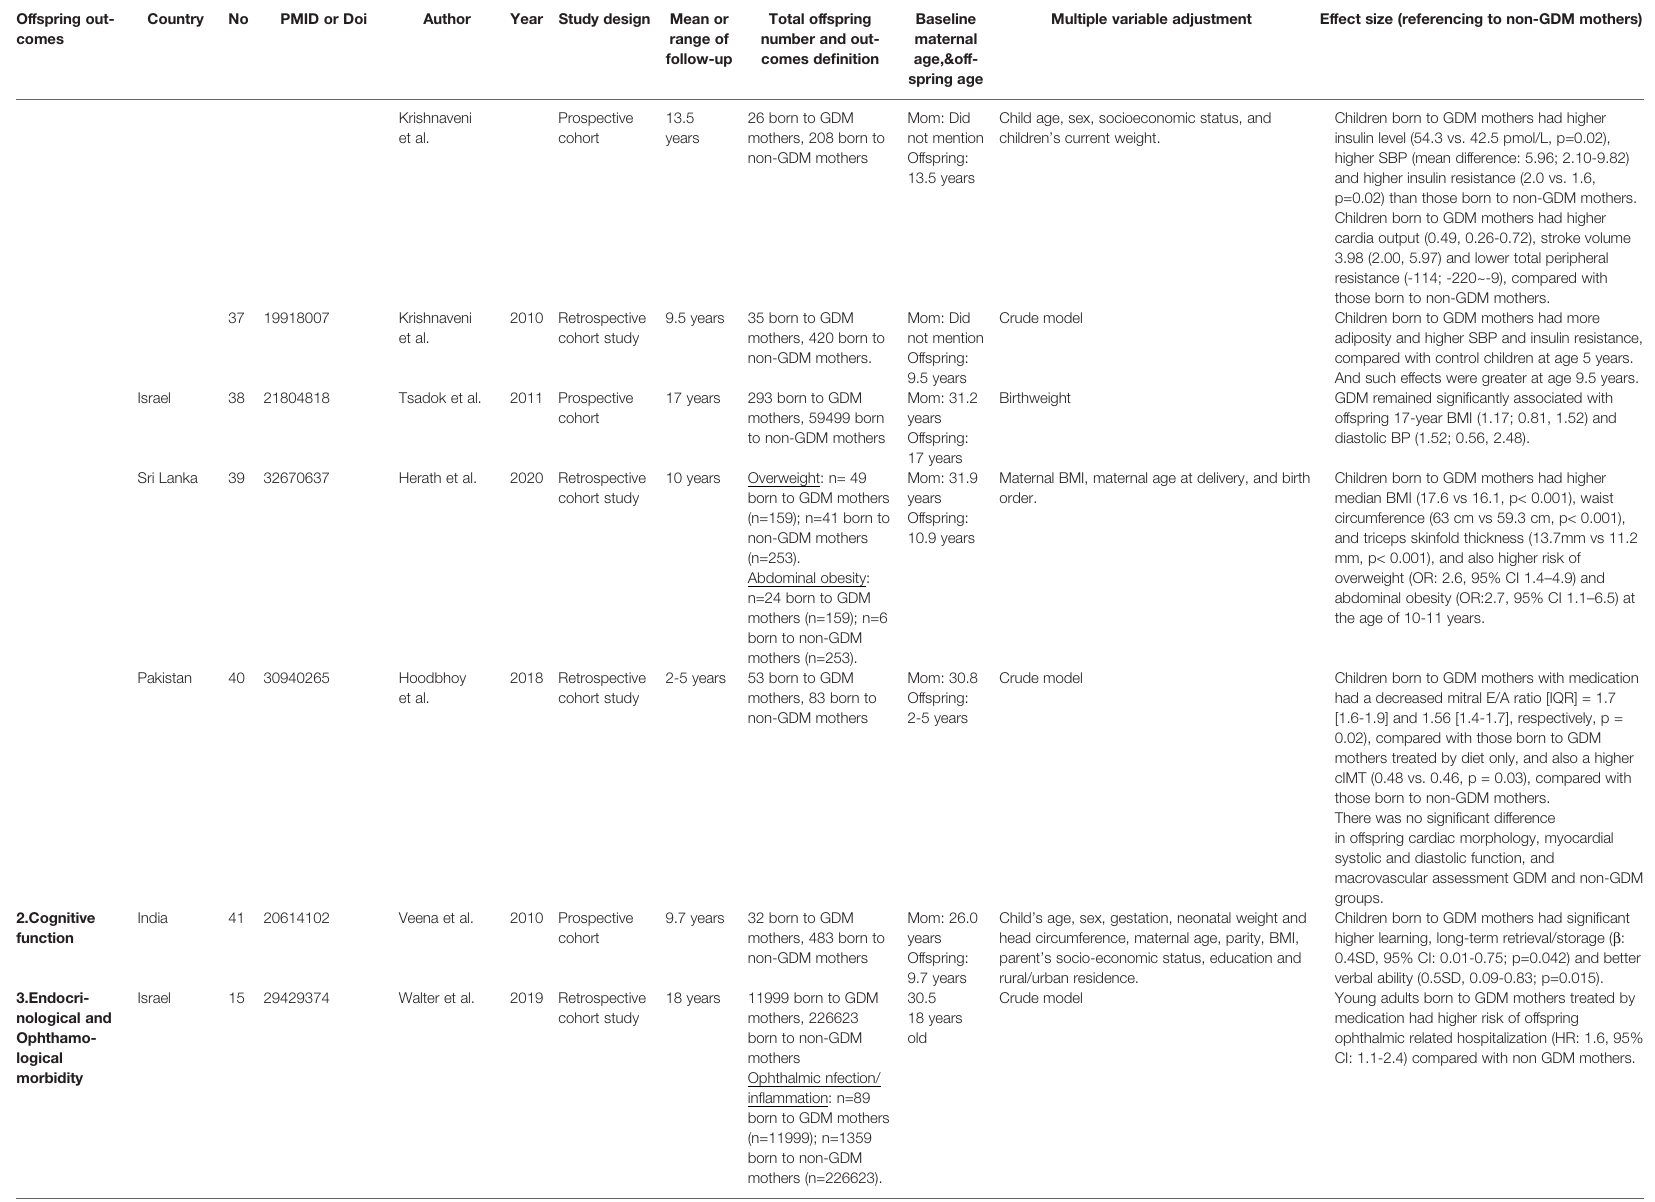
G e s t a t i o n a l D s i n A s i a n (Continued)